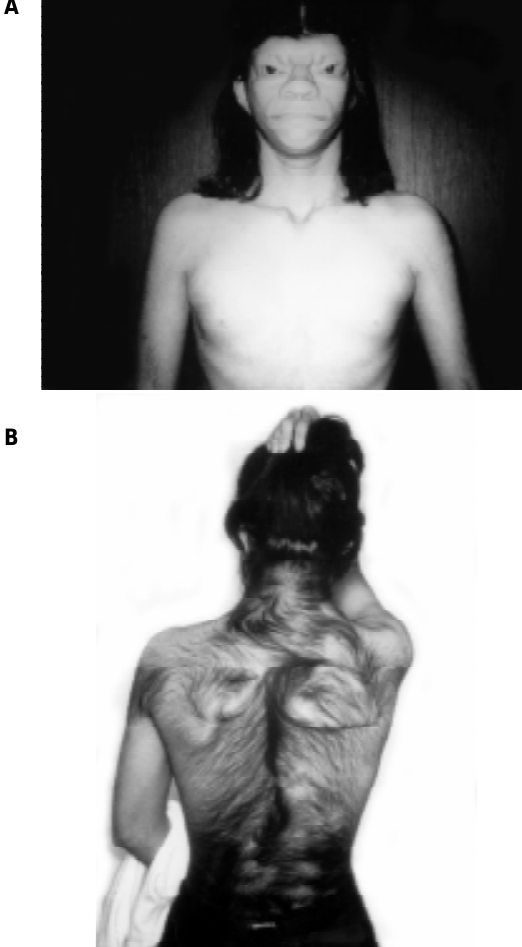
Figure 1 - A : Frontal view of the patient at age 14; B : dorsal view of the patient at age